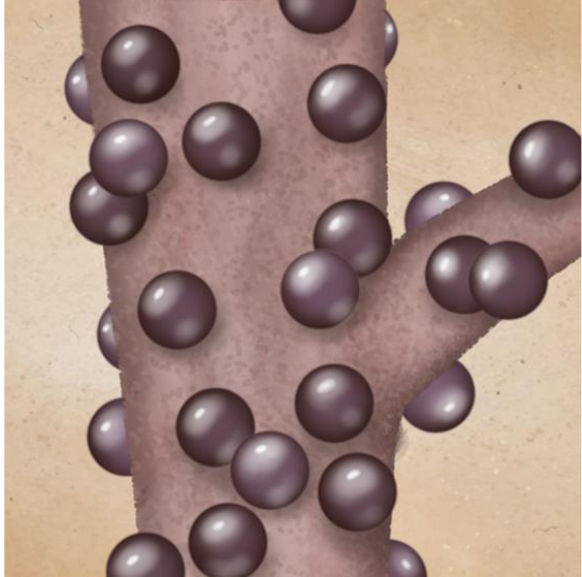
Figure 5. Jabuticaba ( P. cauliflora ). Illustration made by the Ribeiro, L.V.